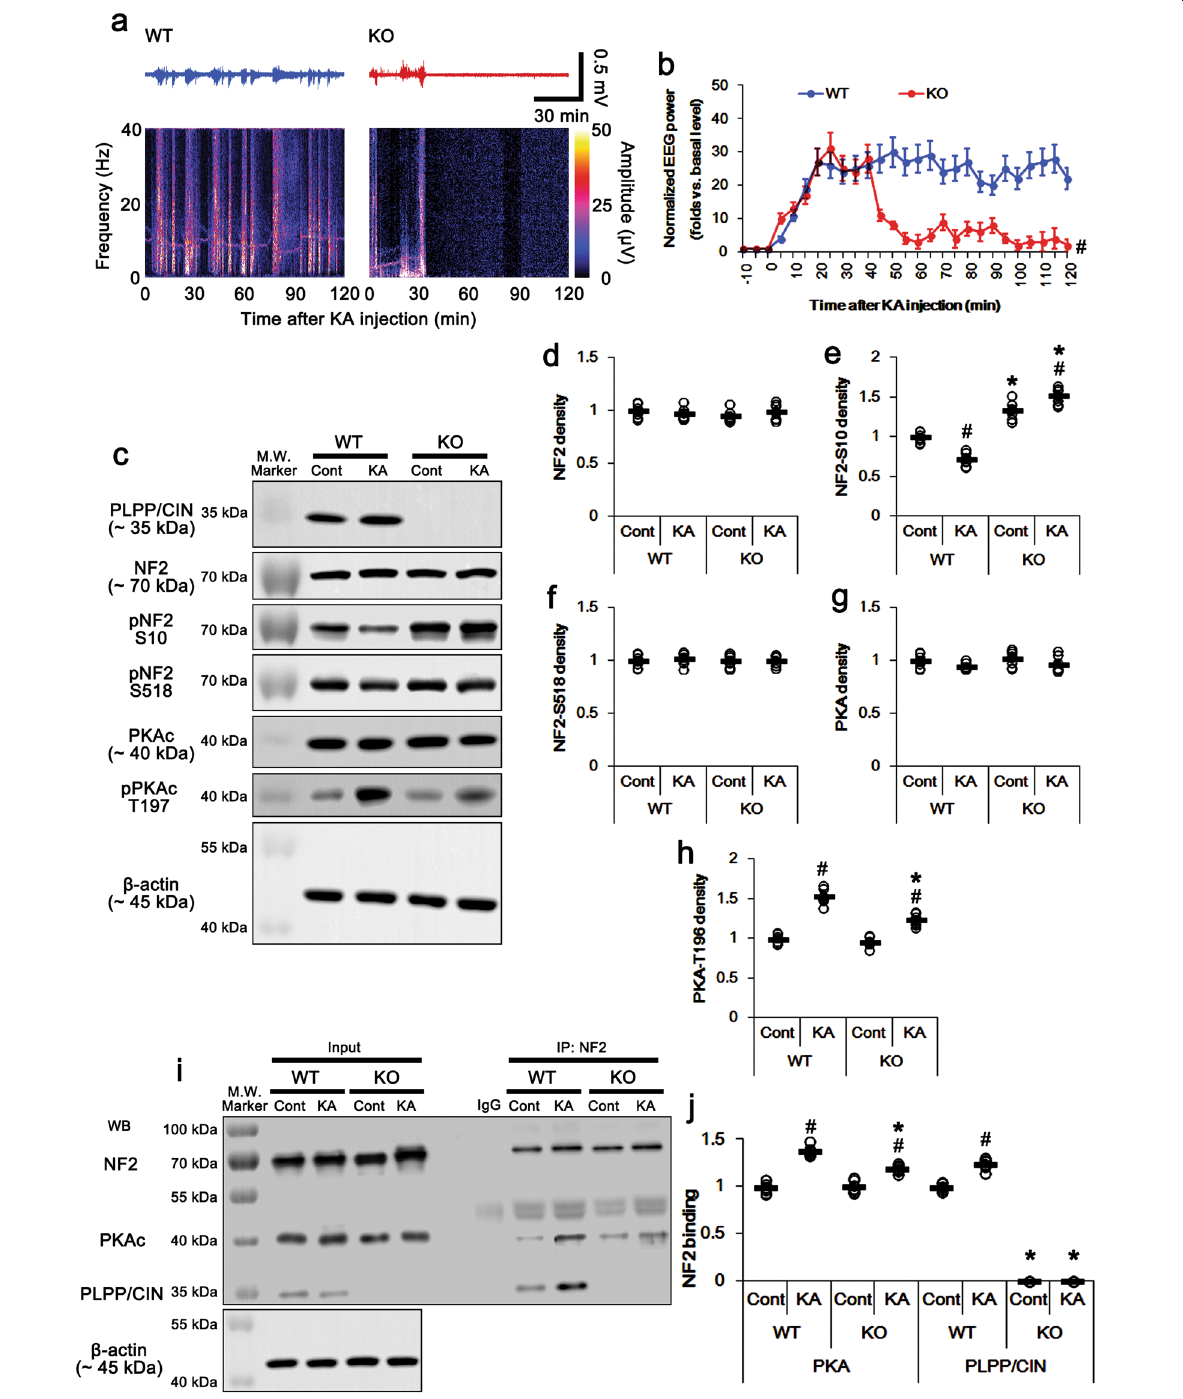
Fig. 3 Effects of PLPP/CIN deletion on seizure activity, NF2 phosphorylation, and PLPP/CIN-NF2 binding in response to KA. a Representative EEG traces and frequency-power spectral temporal maps in response to KA. b Quanti fi cation of total EEG power (seizure intensity) in response to KA ( # p < 0.05 vs. WT animals; n = 7, respectively). c Representative western blots of PLPP/CIN, NF2, pNF2-S10, pNF2-S518, PKAc, and pPKAc in WT and and PLPP/CIN Tg mice in vivo. d – h Quanti fi cation of NF2, pNF2-S10, pNF2-S518, PKAc, and pPKAc levels. Open circles indicate each individual value. Horizontal bars indicate mean value (* ,# p < 0.05 vs. WT and control animals, respectively; n = 7). i , j Effects of KA on PLPP/CIN-NF2 and -PKAc bindings in WT and PLPP/CIN − / − mice in vivo. i Representative co-immunoprecipitation data demonstrating PLPP/CIN-PKAc and NF2 bindings. j Quanti fi cation of PLPP/CIN-PKAc and -NF2 bindings. Open circles indicate each individual value. Horizontal bars indicate mean value (* ,# p < 0.05 vs. WT and control animals, respectively; n =